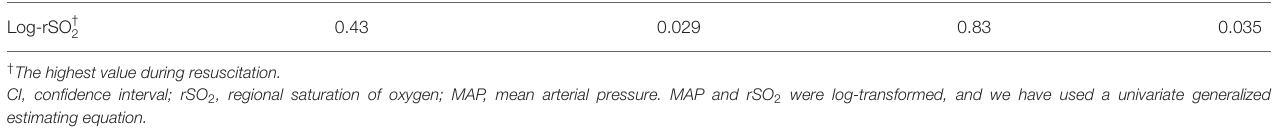
TABLE 2A | Regression coefficients with MAP and rSO 2 . Log-MAP